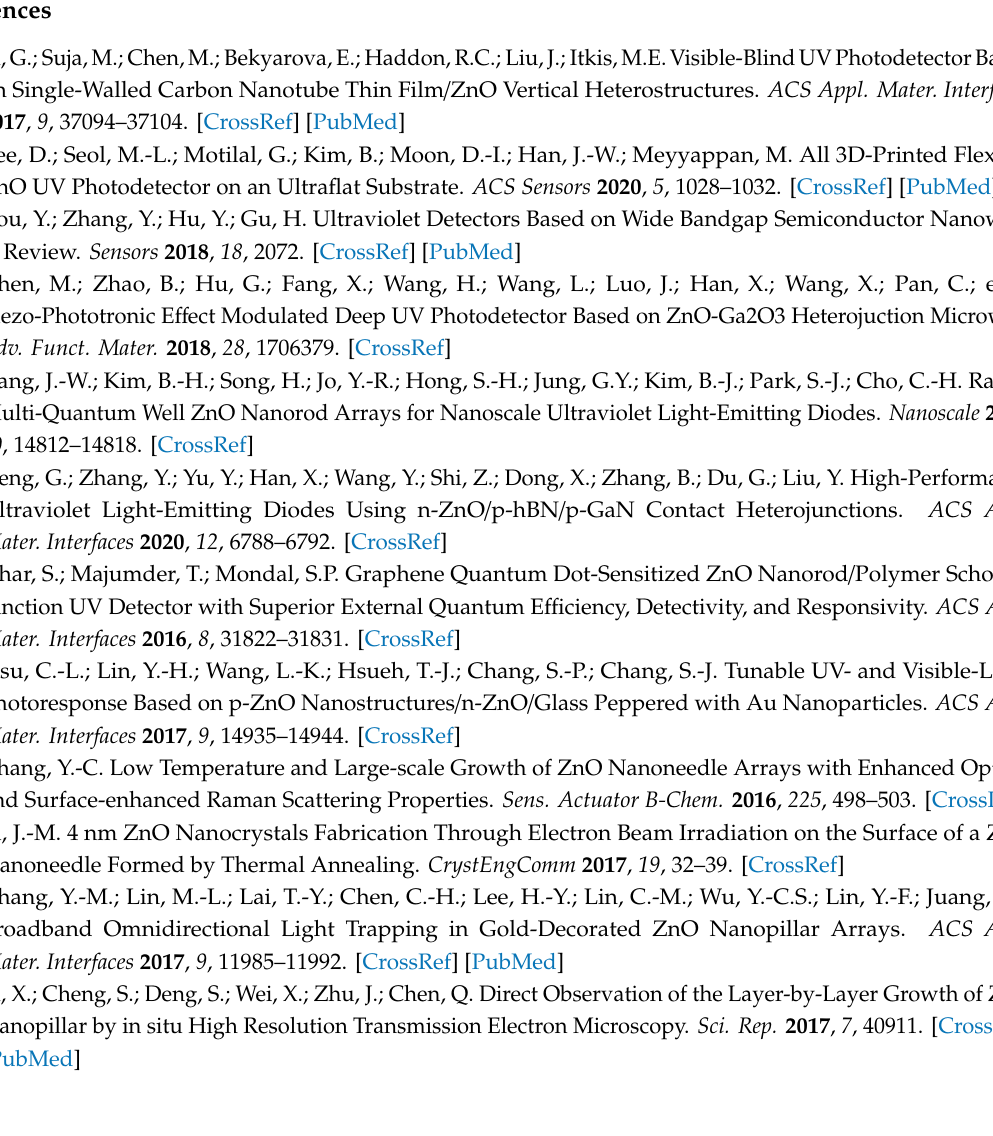
Figure S1: Optical absorption spectra of PFO, YZO-NRs, and PFO / YZO-NRs; Figure S2: Energy band diagrams of the PFO / YZO-NR heterojunction: (a) before contact, (b) at thermal equilibrium, (c) under forward bias, and (d) under reverse bias. E F , E c , and E v in (a) denote the Fermi level, conduction band, and valence band,